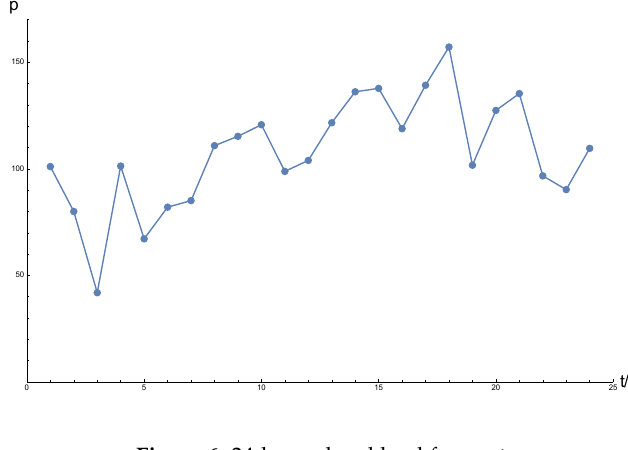
Figure 6. 24-hour ahead load